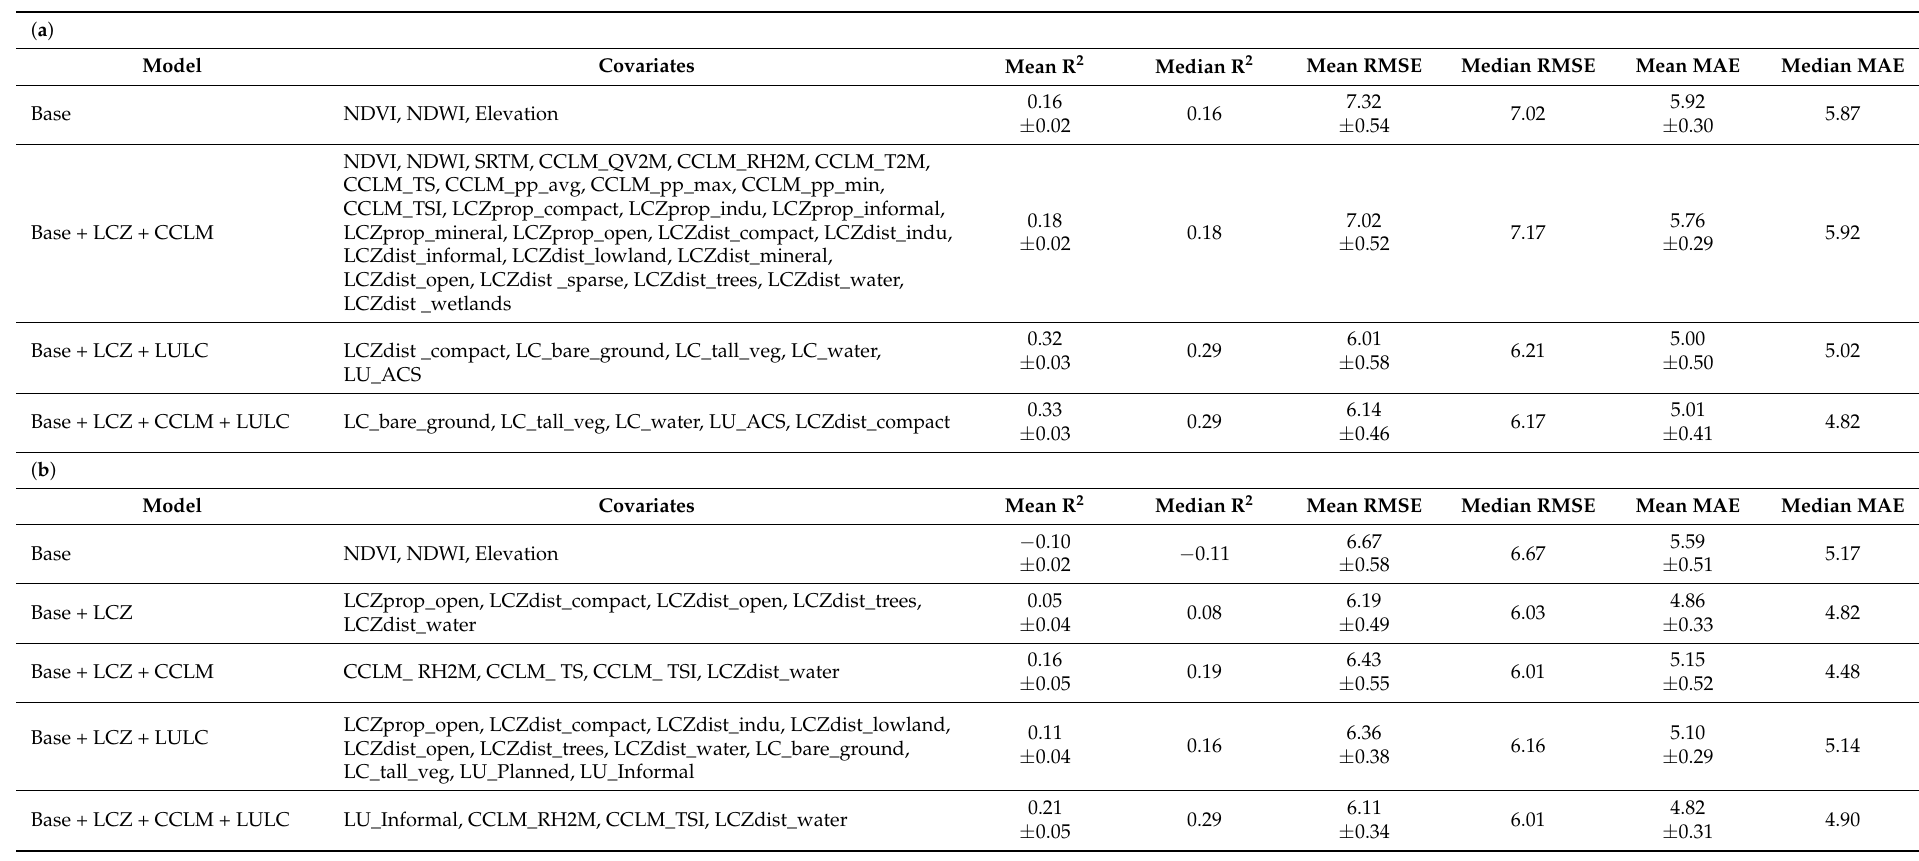
Table 2. Model performances (average with 95% confidence intervals and median) in terms of R-squared, RMSE and MAE for the five different models of ( a ) Dar es Salaam and ( b ) Kampala. The table also includes the covariates remaining after the RFE variable